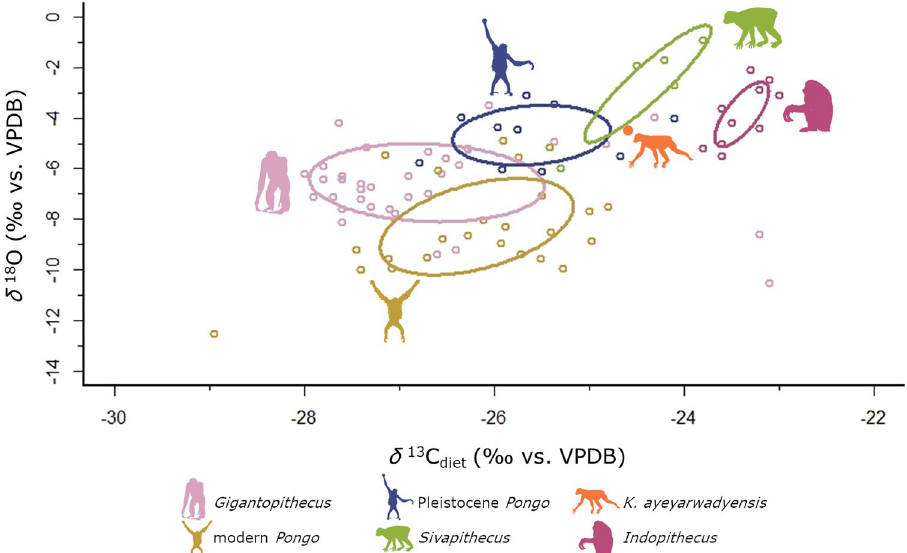
Figure 5. Bayesian niche modelling of fossil and extant pongines. The lines encompass the standard ellipse area or core ecological niche, corresponding to a confidence interval of 40% 60 . Icons are public domain ( Gigantopithecus , Indopithecus ) or Creative Commons 3.0 license [modern and Pleistocene Pongo by Gareth Monder, Khoratpithecus by Mateus Zica (modified by T. Michael Keesey), and Sivapithecus by Nobu Tamura (modified by T. Michael Keesey)] via